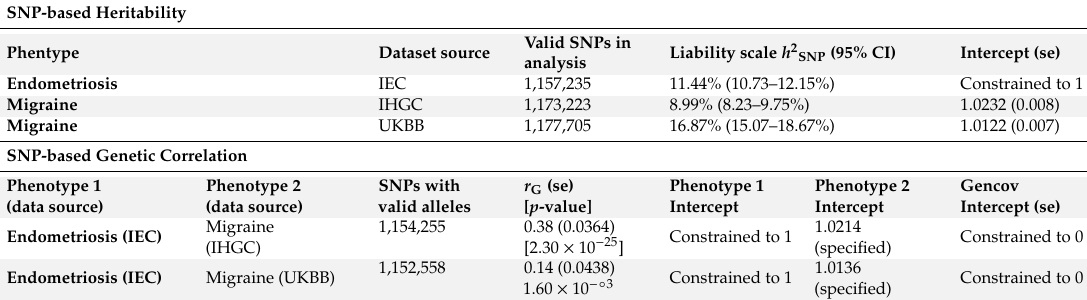
Table 2. Linkage disequilibrium (LD) score regression